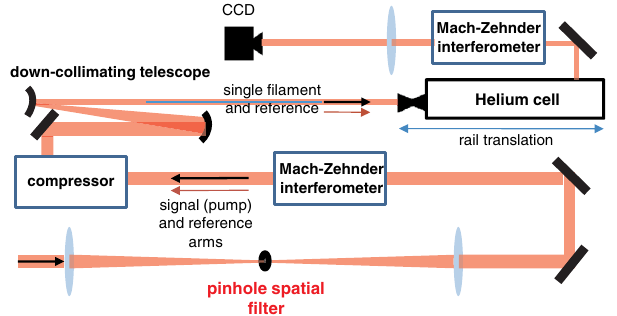
FIG. 7. Experimental setup for measuring the in-flight intensity and spatial phase profiles of collapsing and filamenting femto- second pulses over a ∼ 2 m range.